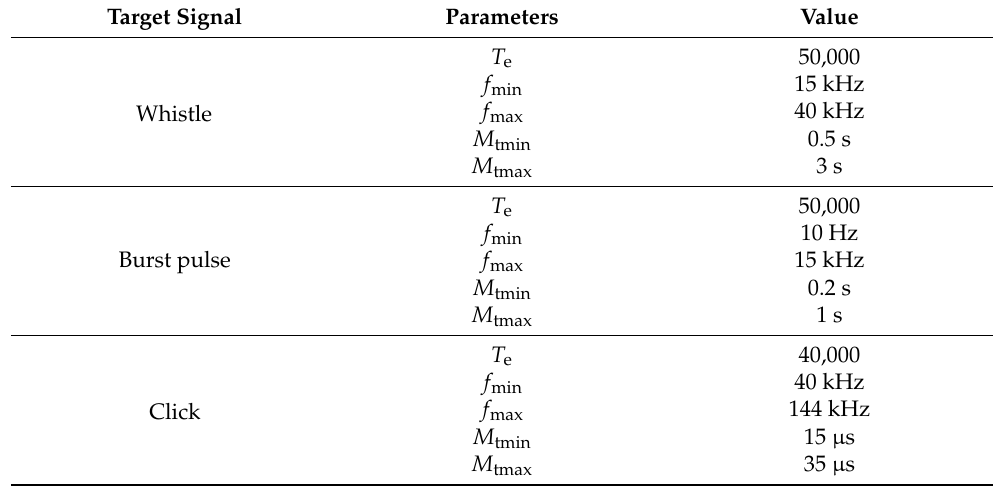
Table 4. Parameters for